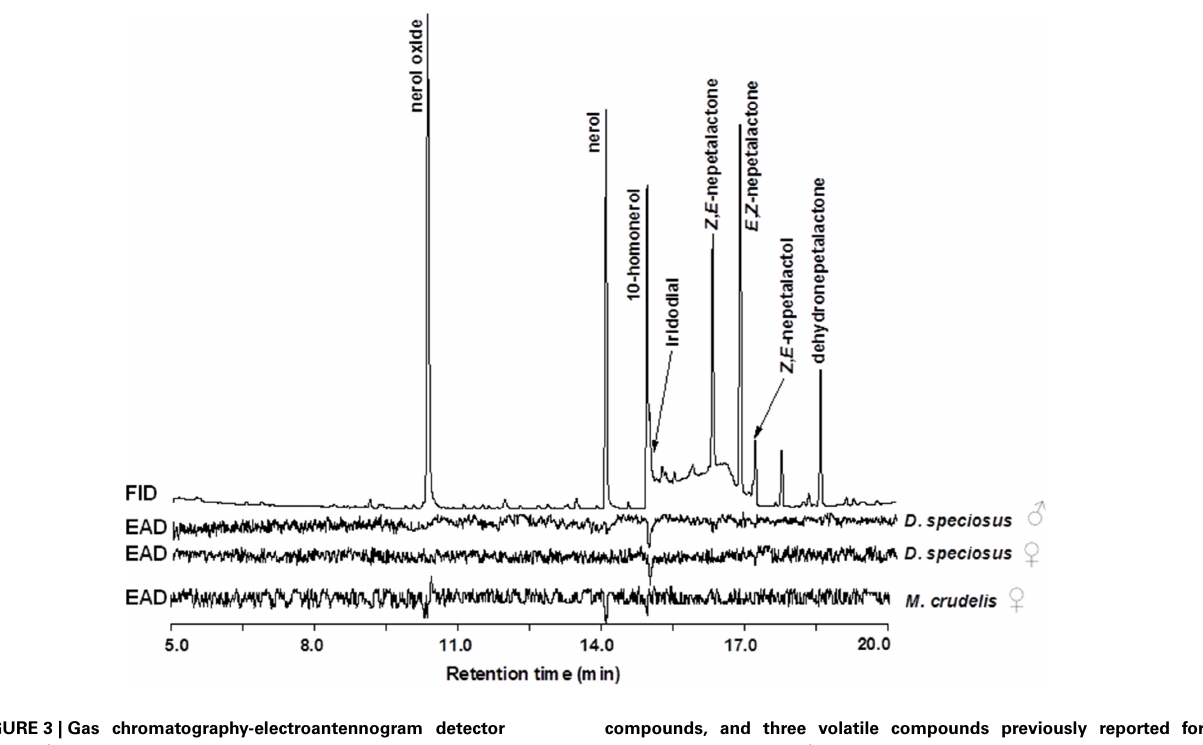
compounds, and three volatile compounds previously reported for other antlion species (200ng/ µ l each in hexane; see text for